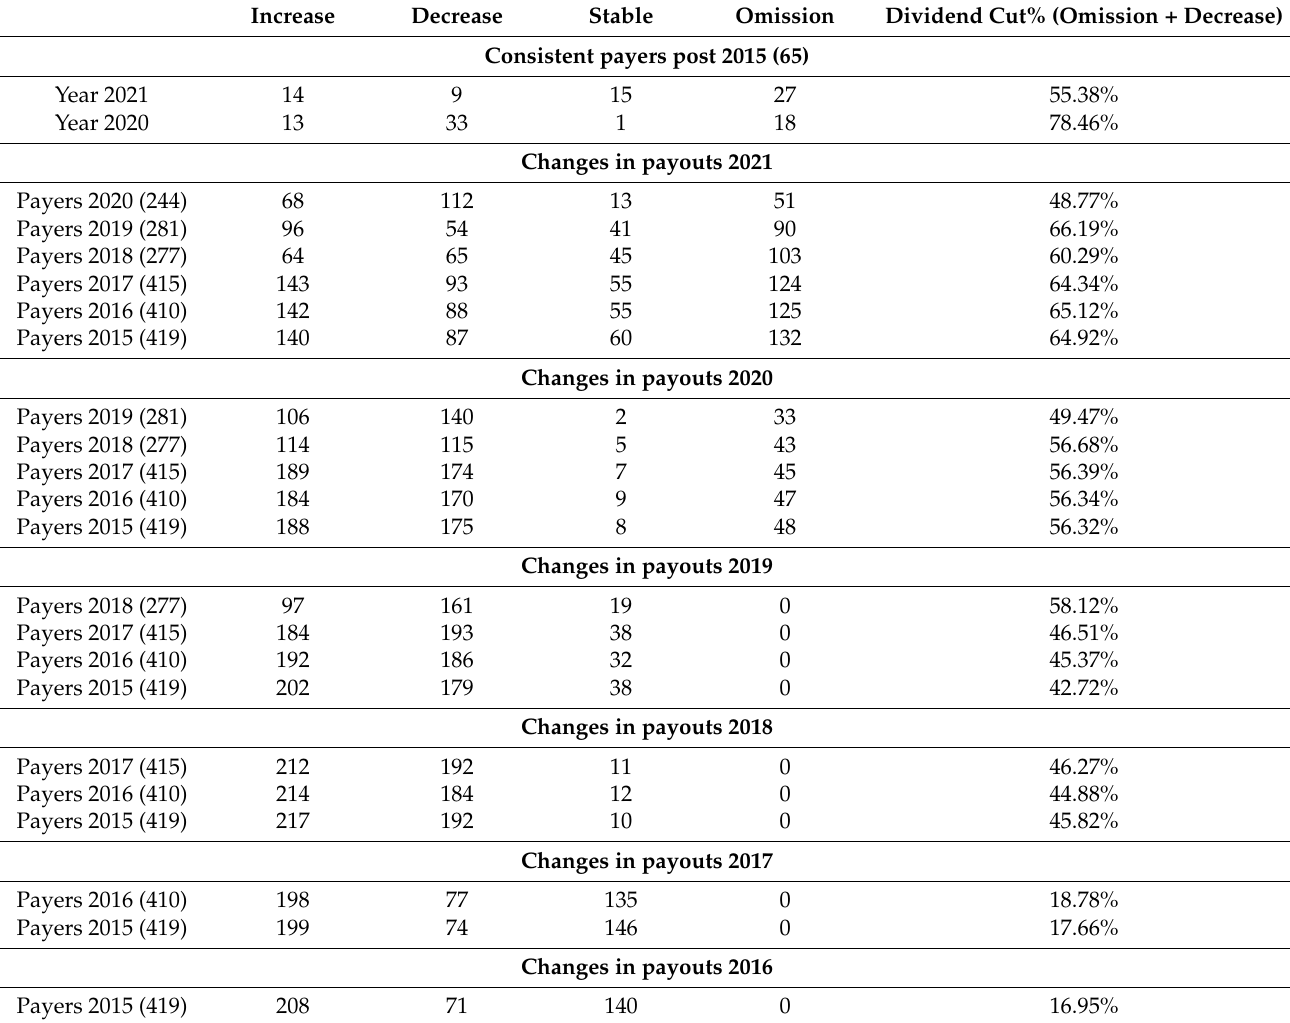
Table 3. Trend of changes in the dividend payout.